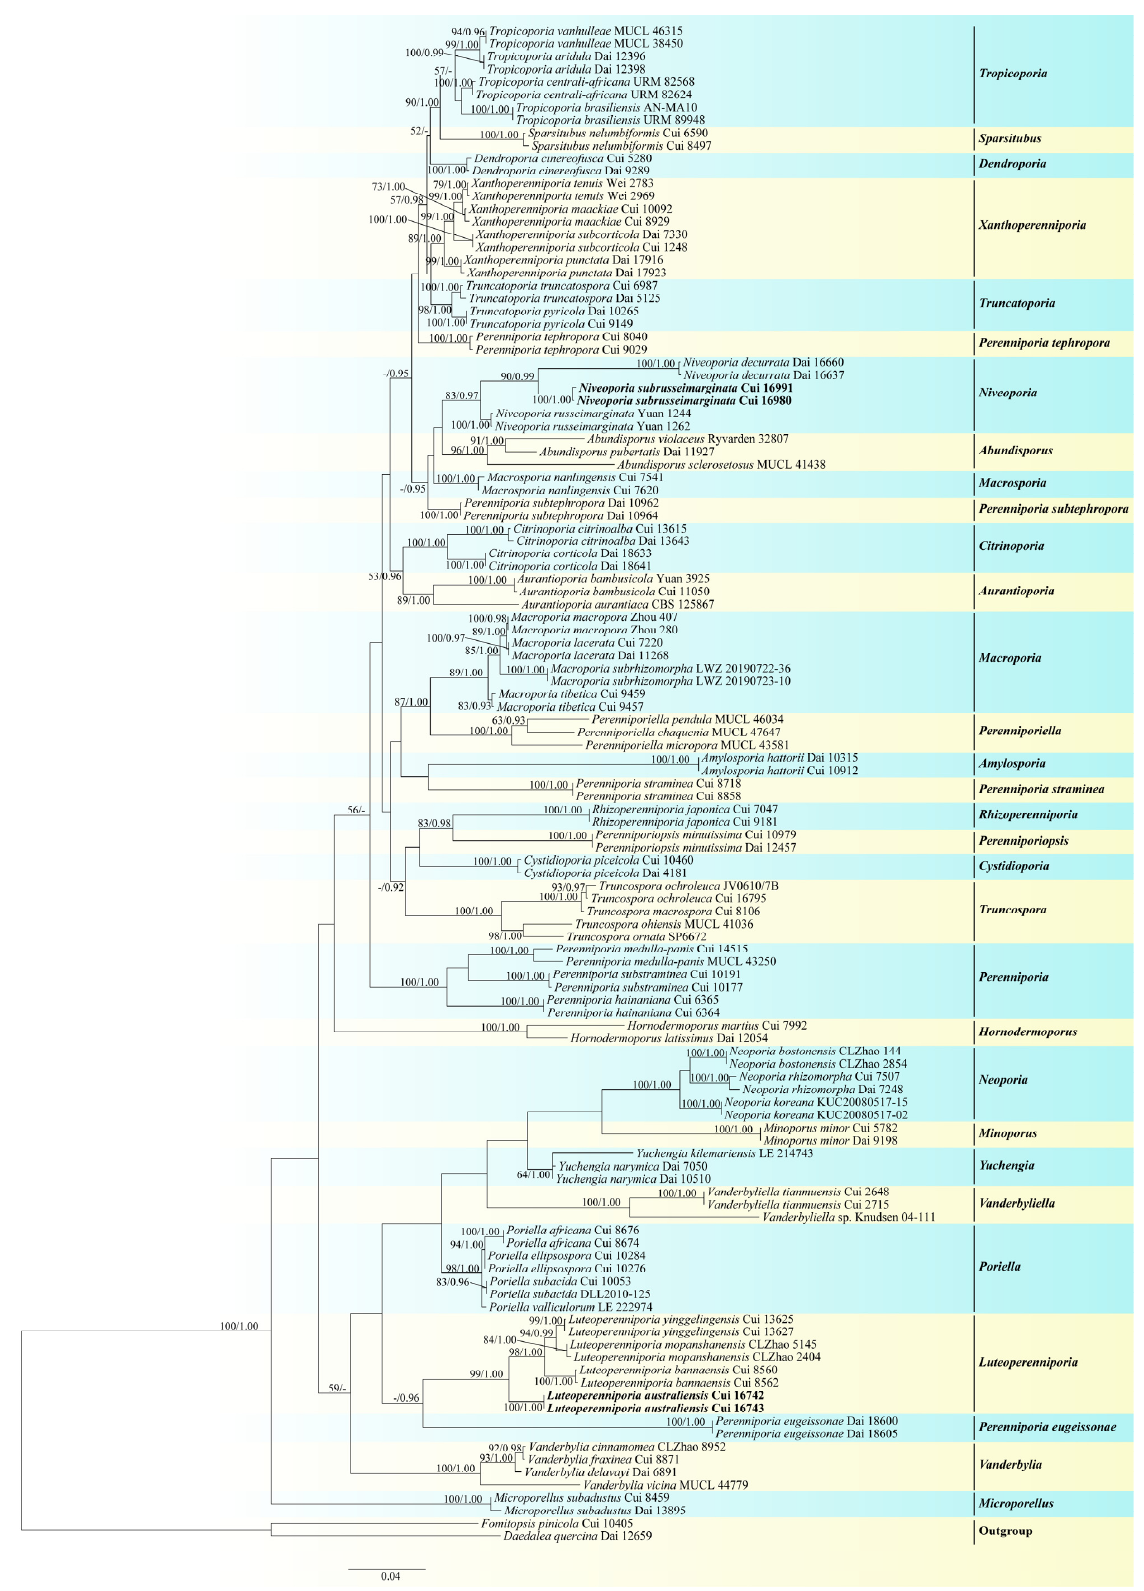
Figure 2. Maximum likelihood tree illustrating the phylogeny of Perenniporia and related genera based on the ITS + nLSU + mtSSU + TEF1 + TBB1 dataset. Branches are labeled with maximum likelihood bootstrap support values ( ≥ 50%) and Bayesian posterior probabilities ( ≥